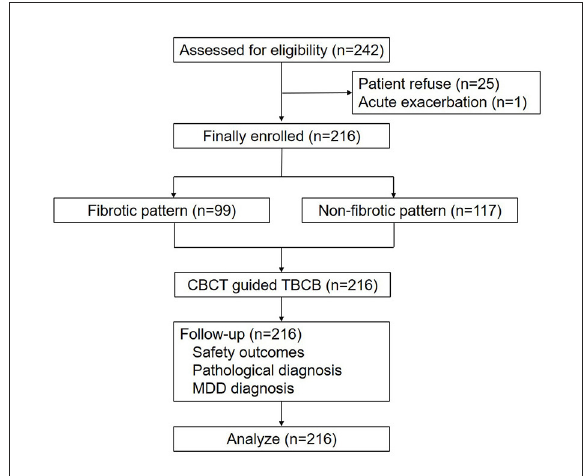
FIGURE1 Flow diagram of the enrolment and follow-up processes for the patients who underwent transbronchial cryobiopsy (TBCB).